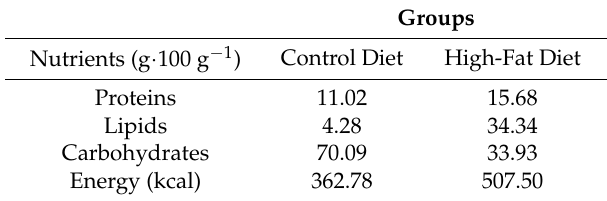
Table 1. Chemical compositions of the control and high-fat diets used in this study (g · 100 g − 1 ).